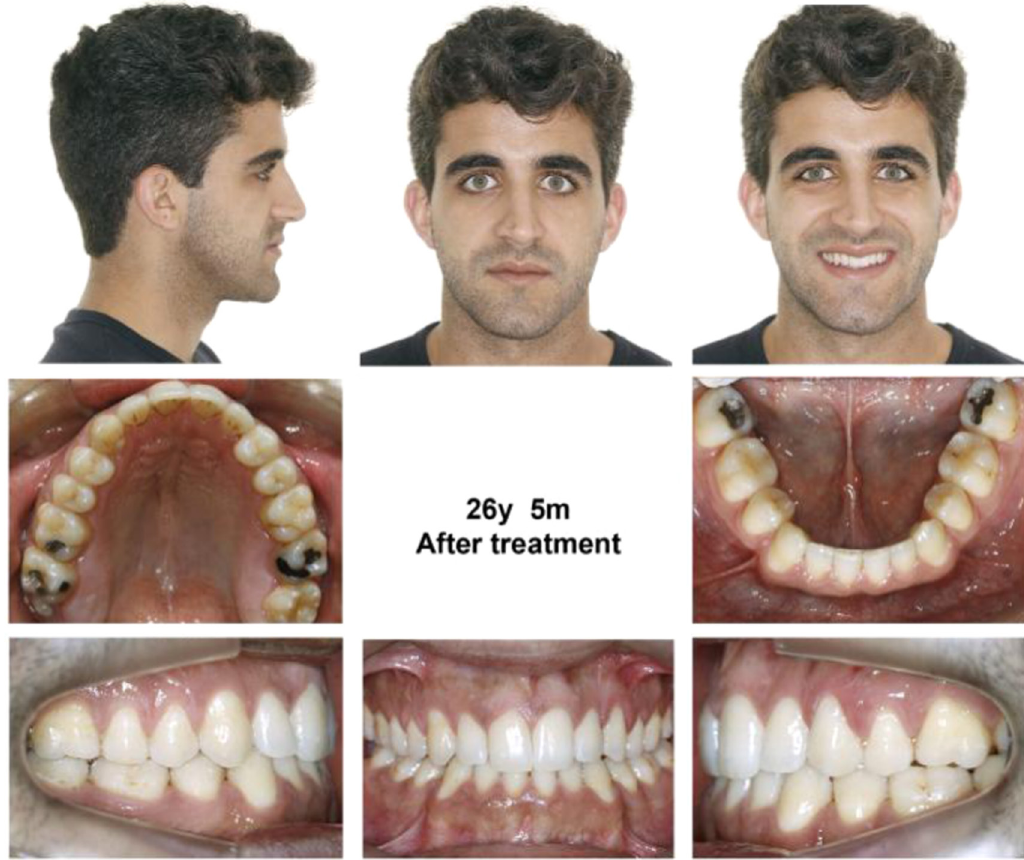
Figure 6. Extra- and intra-oral photographs after 5 year